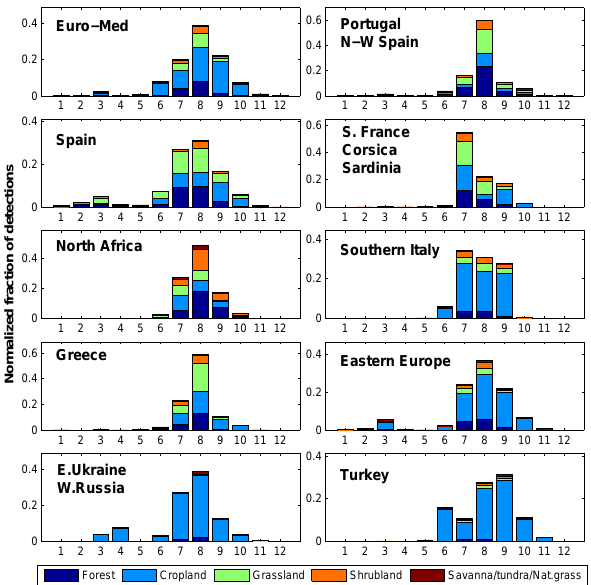
Fig. 5. Fraction of area burned detections located in different vegetation types for the CLC (grouped vegetation classes at 1km resolution). For North Africa, Ukraine and Russia, the MODIS land cover is used. Fig. 6. Hourly variation of the number of fires detected by the MSG/SEVIRI instrument (left pannel) and of the average FRP measurements over several subregions of the domain for the 2008–2010 time period (July–August only). The red line shows the corresponding averaged diurnal cycle.